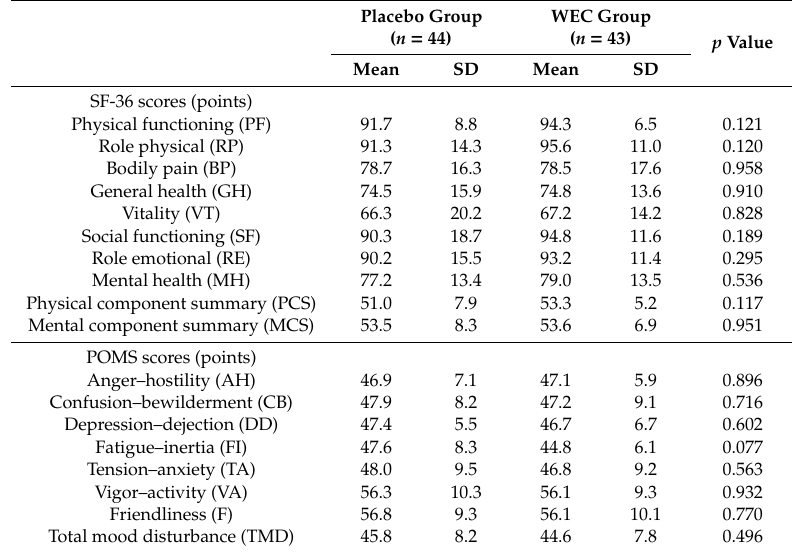
Table 3. Baseline scores for the MOS 36-item short-form health survey (SF-36) and Profile of Mood States (POMS) questionnaire 1